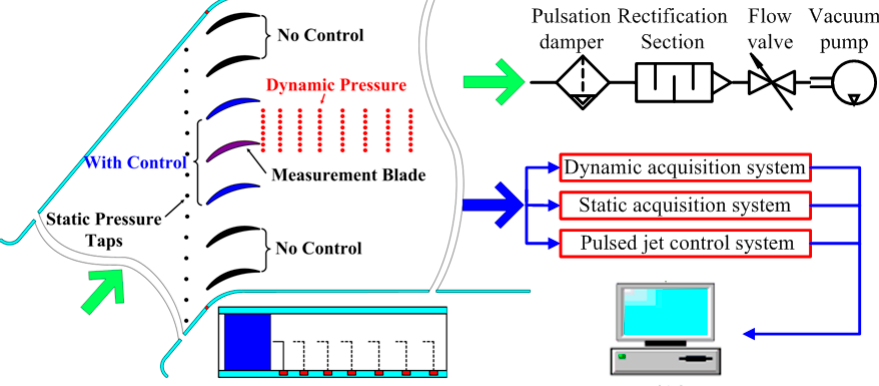
Figure 18. Schematic diagram of the test system.